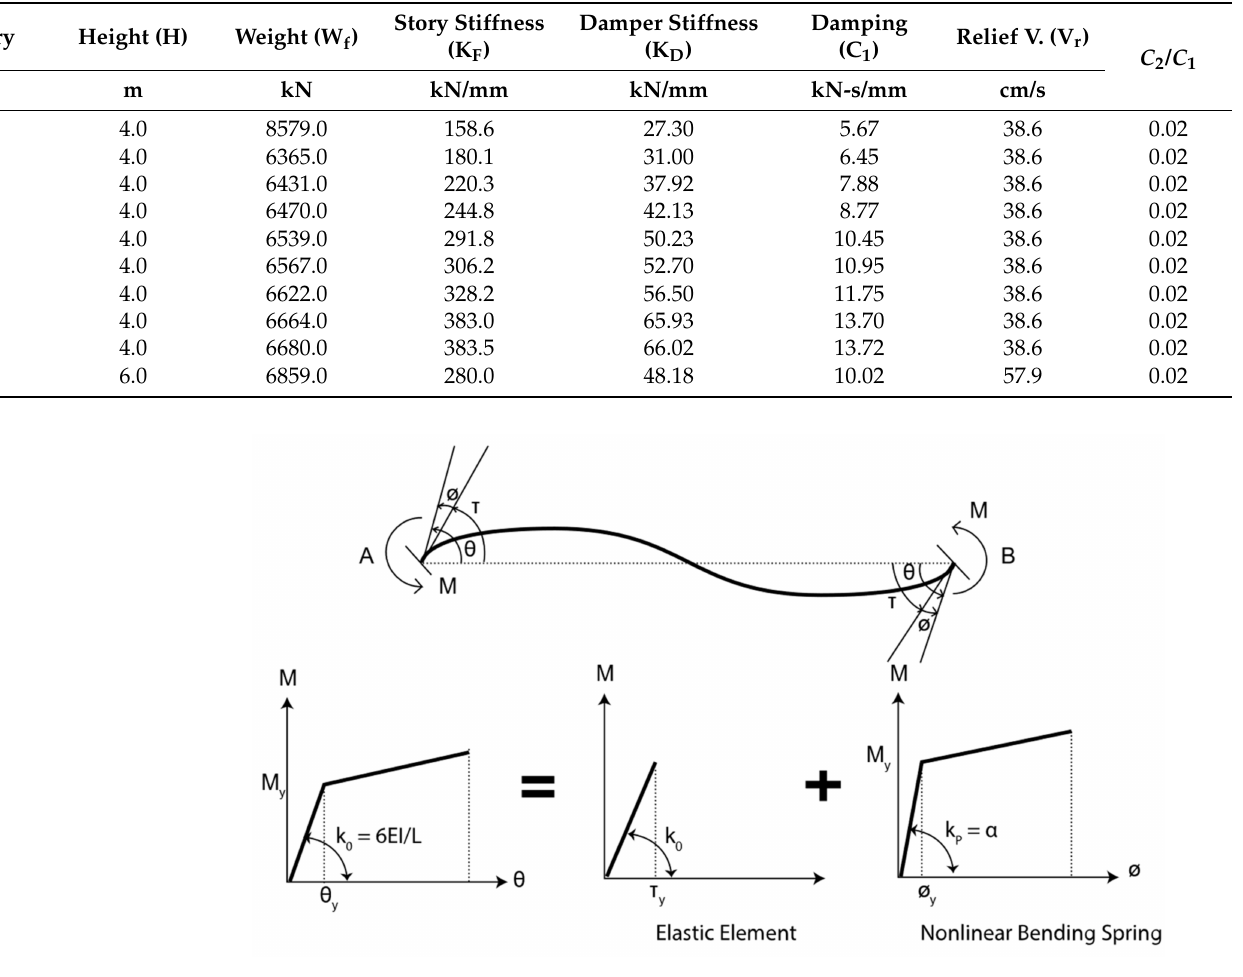
Figure 7. Moment–rotation relationship at bending spring of beam and column elements. The bilinear-type oil damper is defined as a vertical line element with a shear spring in the middle. The shear spring consists of the Maxwell model with an elastic spring with stiffness, K D , and a dashpot with a bilinear-type damping coefficient, C , connected in a series. The force–velocity relation of the dashpot is shown in Figure 8.